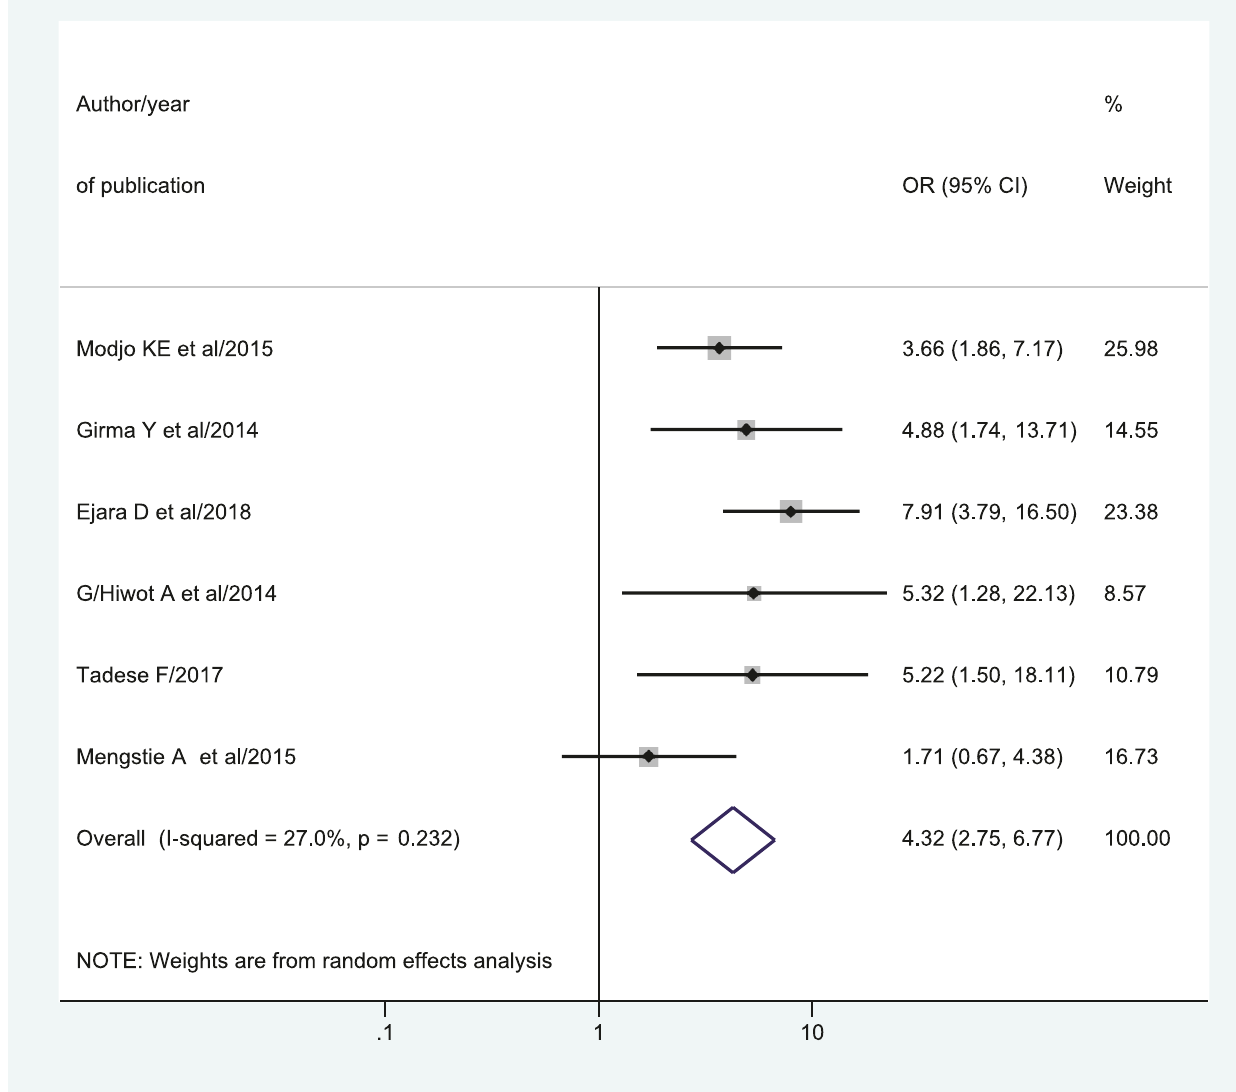
Figure 5: Forest plot of odds ratio of counseling with 95%CI. The midpoint and the length of each segment revealed OR and 95%CI. The diamond shape showed pooled